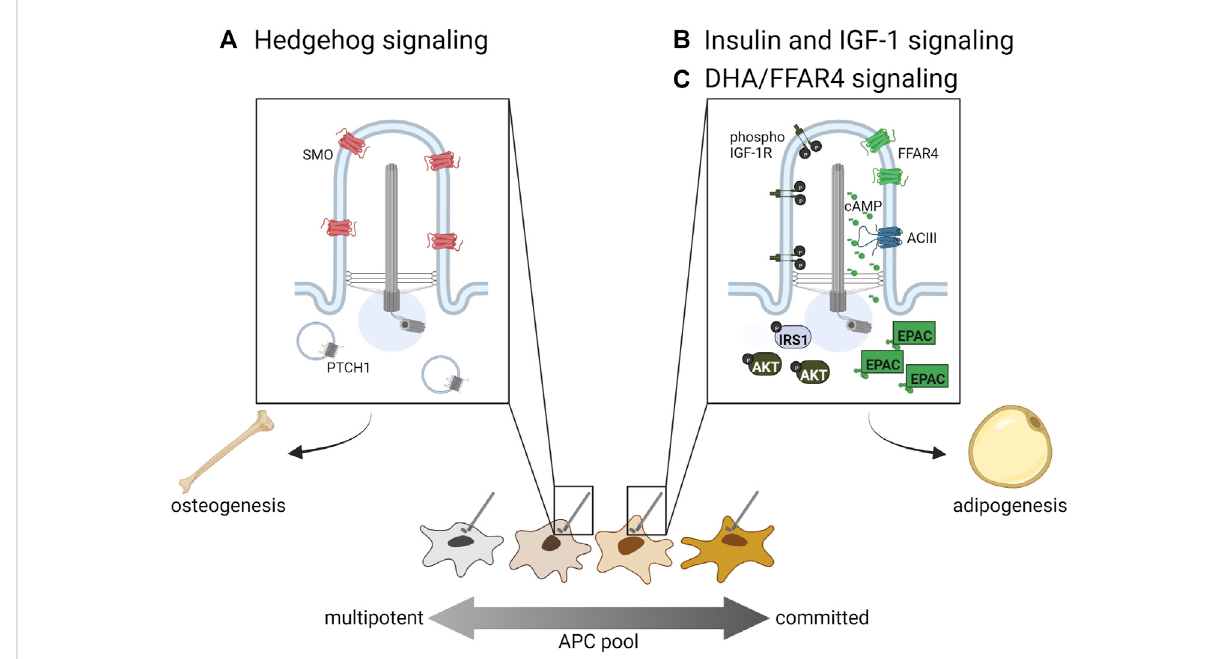
FIGURE 2 Ciliary signaling pathways regulating APC fate. (A) Hedgehog signaling inhibits adipogenic lineage commitment and hence adipogenesis, while (B) insulin,IGF-1R,and (C) omega-3fattyacidssuchasDHApromoteadipogenesis via primarycilia-localizedreceptors.DistinctAPCsubpopulations may display differential sensitivity to these ciliary signals directing cell